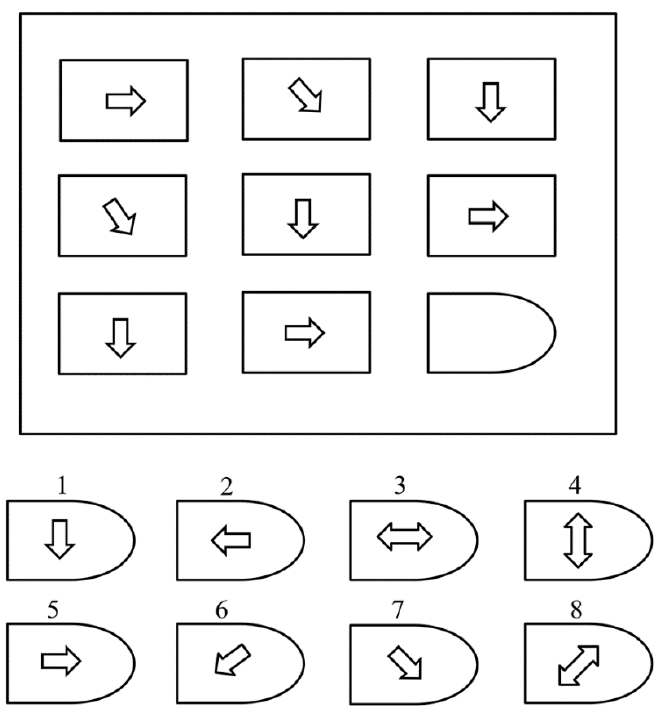
Figure 1. An example of a Raven’s Advanced Progressive Matrix (RAPM) problem.